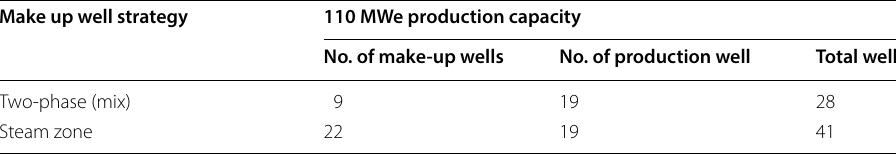
Table 8 Total wells needed for 110 MW of 30 years production Make up well